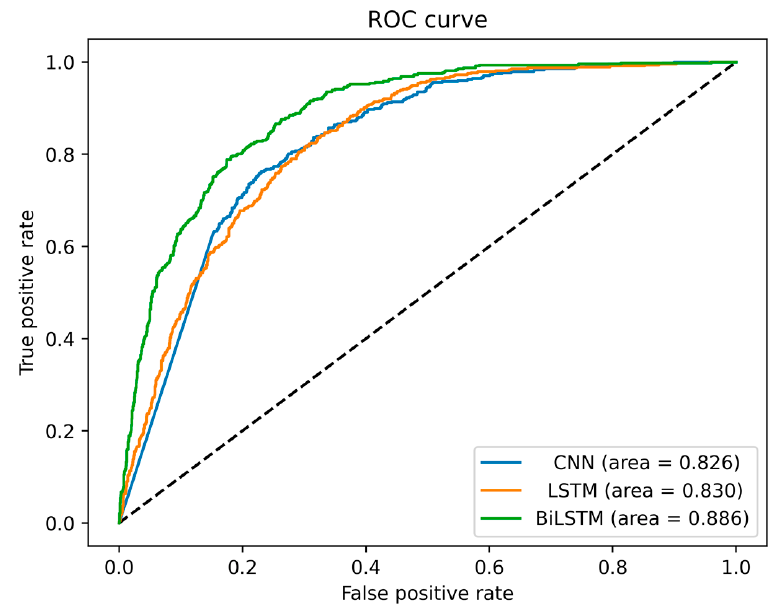
Figure 3. Receiver operating characteristic curves of CNN, LSTM, and BiLSTM.